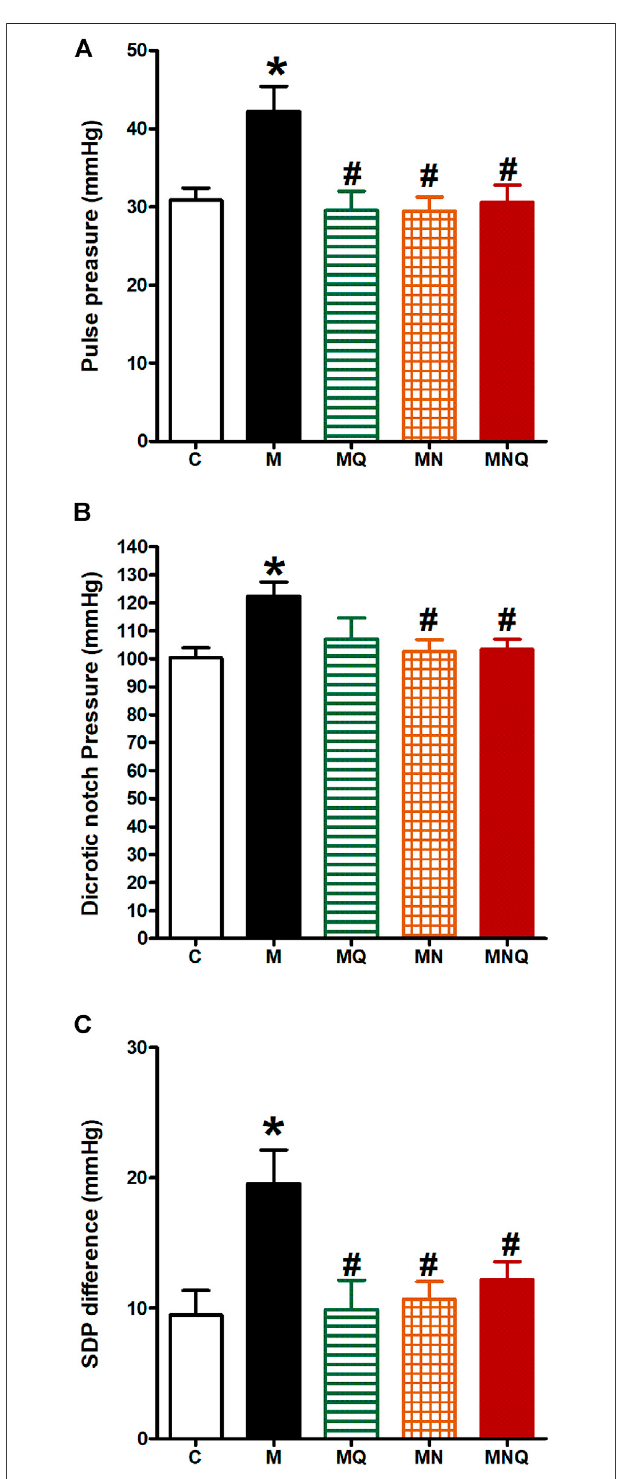
FIGURE 4 | Effect of oral administration of standard quercetin suspension (MQ), plain nano-pharmaceutical formulation (MN) and the quercetin loaded nano-pharmaceutical formulation (MNQ) both at 83 μ mol/kg/day on pulse pressure (A) , dicrotic notch pressure (B) and SDP difference (C) in metabolic syndrome (M) induced by feeding rats a high